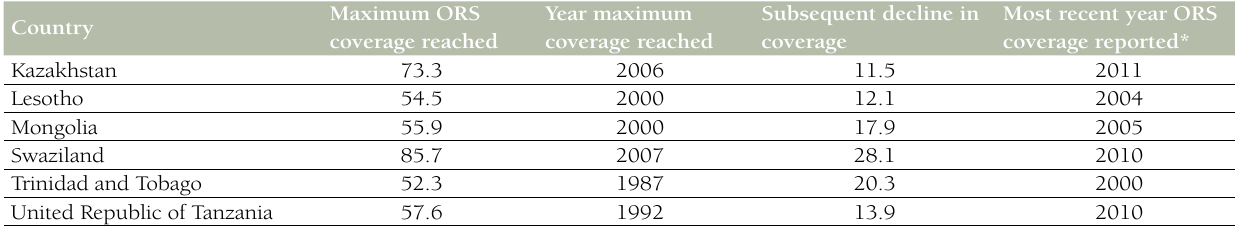
Table 2. Countries meeting the criteria for “unsustained success”